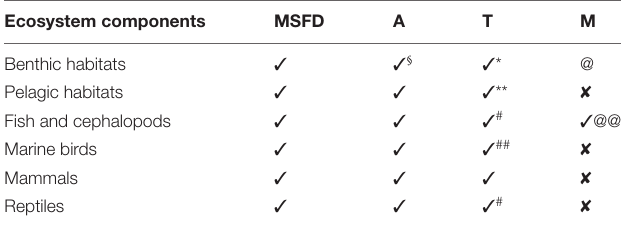
TABLE 3 | List of ecosystem components identified for Space@Sea, categorized by pressure theme. Ecosystem components